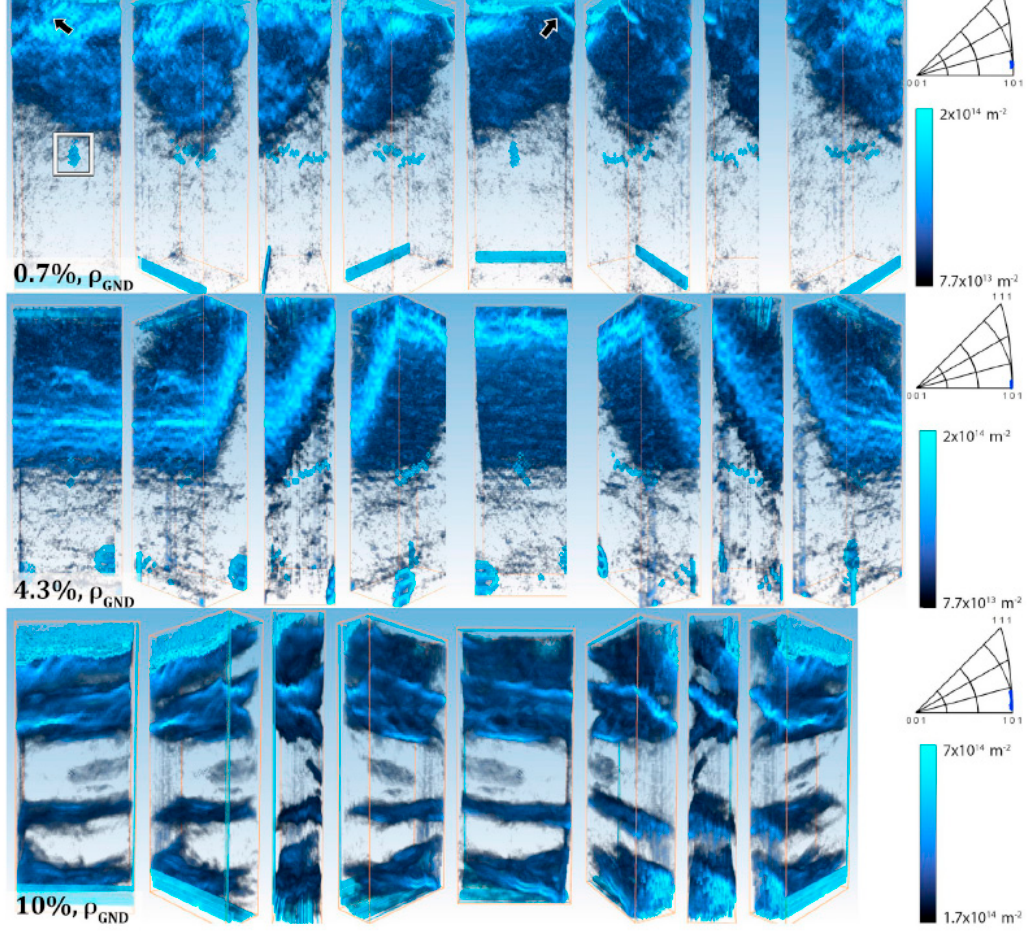
Figure 14. Three-dimensional models of geometrically necessary dislocation density for the three micropillars (the top , middle and bottom rows are referring to 0.7, 4.3 and 10% deformation, respectively), representing an intermediate behavior between bulk and nanoscale plasticity. Well-developed dislocation-cell structure can be observed in the function of deformation. See more details in the Ref. [92]. Reproduced with permission from [92]. Copyright 2020, Elsevier.